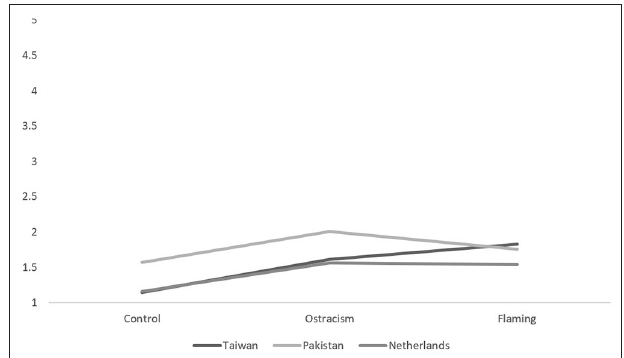
FIGURE 3 | The between-subjects interaction effect between nationality and trolling type for aggressive intentions.